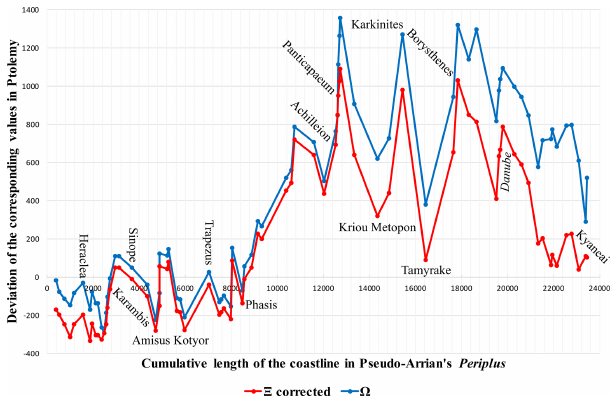
Figure 8. Difference between Ptolemy’s and Pseudo-Arrian’s coastline length data compared geographically. The x axis shows the cumulative sum of the coastal segments in Pseudo-Arrian, mea- sured from the Sanctuary of Zeus anticlockwise around the Pon- tus. The y axis shows the deviation of Ptolemy’s corresponding sum values from Pseudo-Arrian’s sum values. Upward movement of the graph indicates that Ptolemy stretches the coastline relative to Pseudo-Arrian’s data and vice